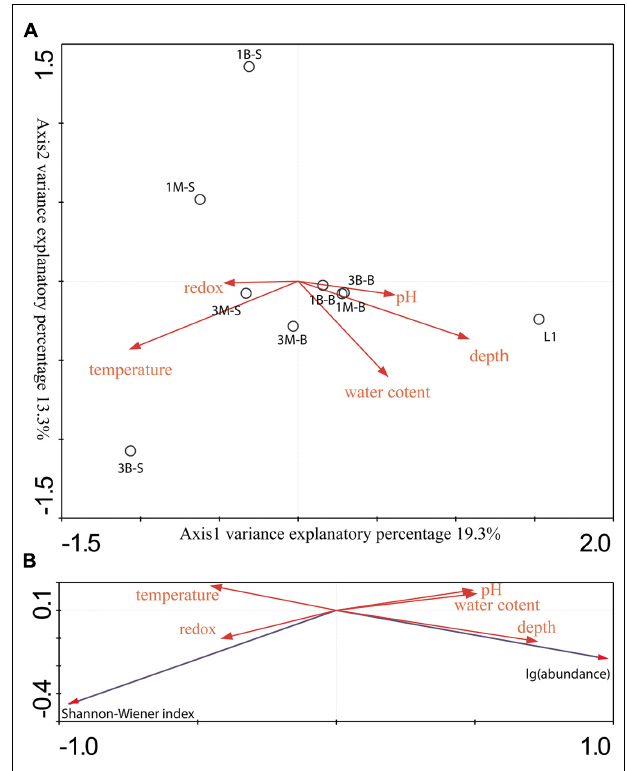
FIGURE 6 | (A) Gradient analysis diagram was drawn by direct Canonical Correlation Analysis method and biplot scaling type by 1000 times setting of Monte-Carlo permutation test to analyze the relationship between sample groups and environmental factors. (B) Gradient analysis was conducted by redundancy analysis (RDA) method and biplot scaling type by 1000 times setting of Monte-Carlo permutation test to show connection between richness and abundance data and environmental